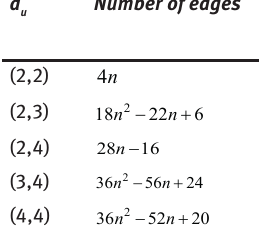
Figure 13: Plot of A ( D